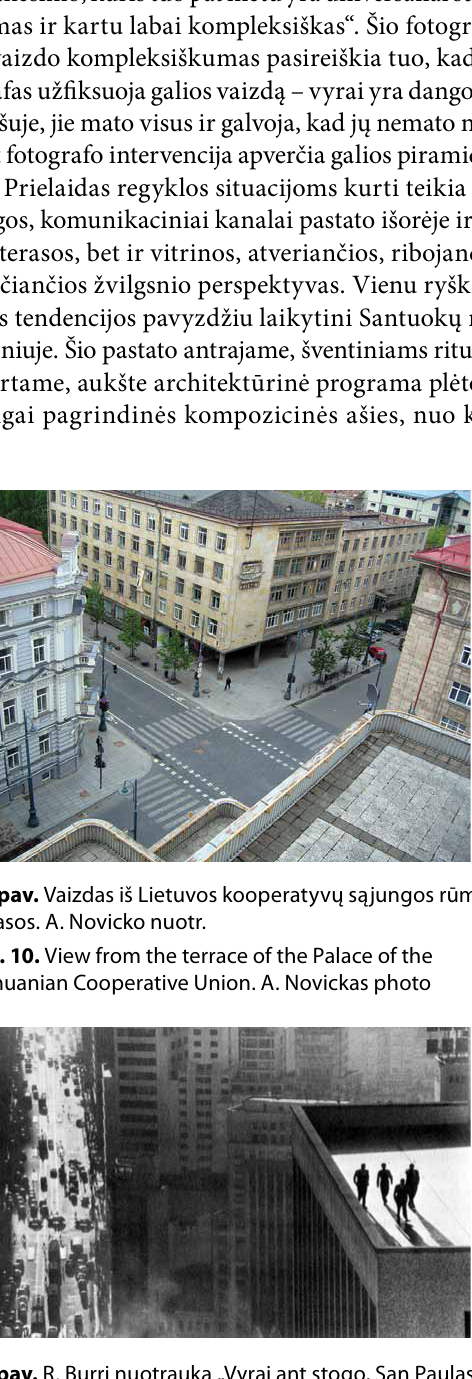
Fig. 11. r. Burri‘s photo “Man on the roof, Sao Paulo, 1960“. Property of Magnum Photos